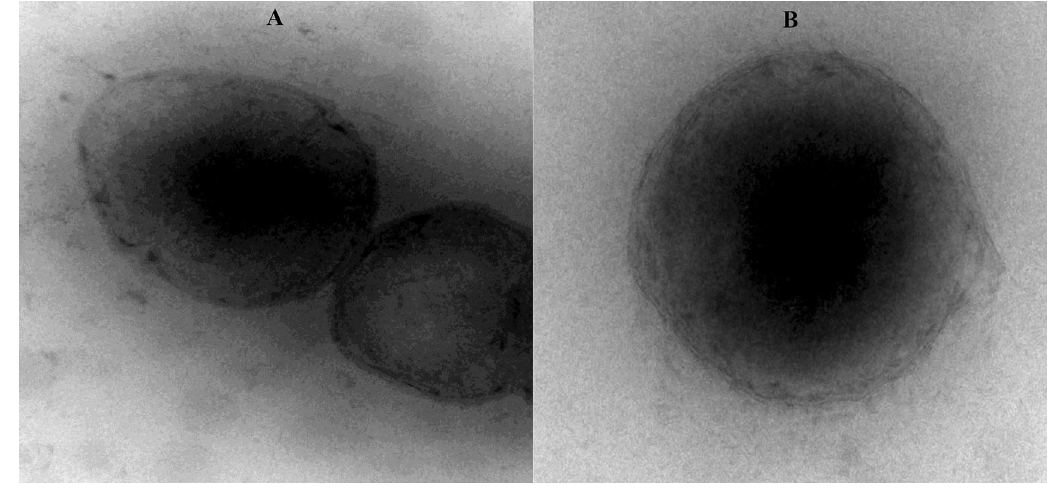
Figure 4. TEM of CLCAE and CLAA.